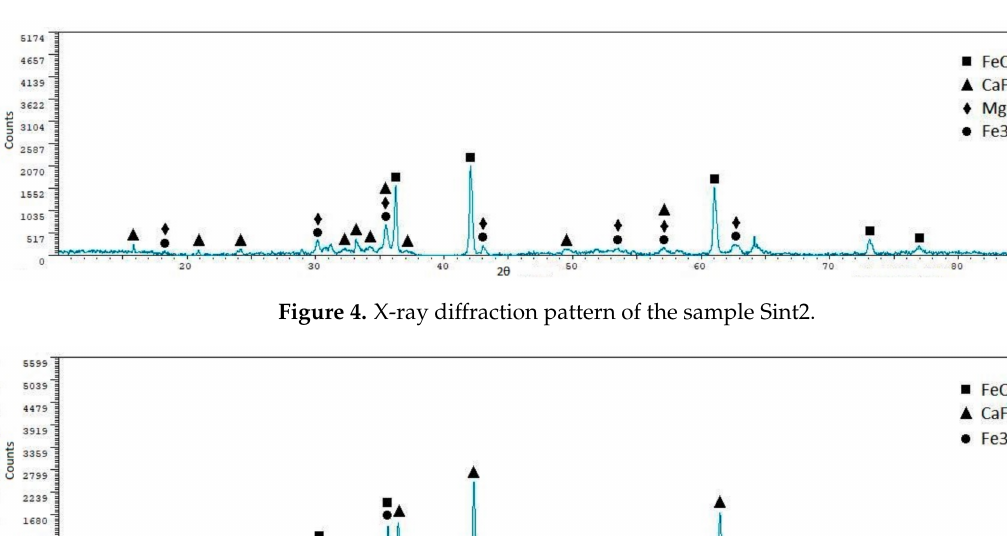
Figure 3. X-ray diffraction pattern of the sample Sint1.